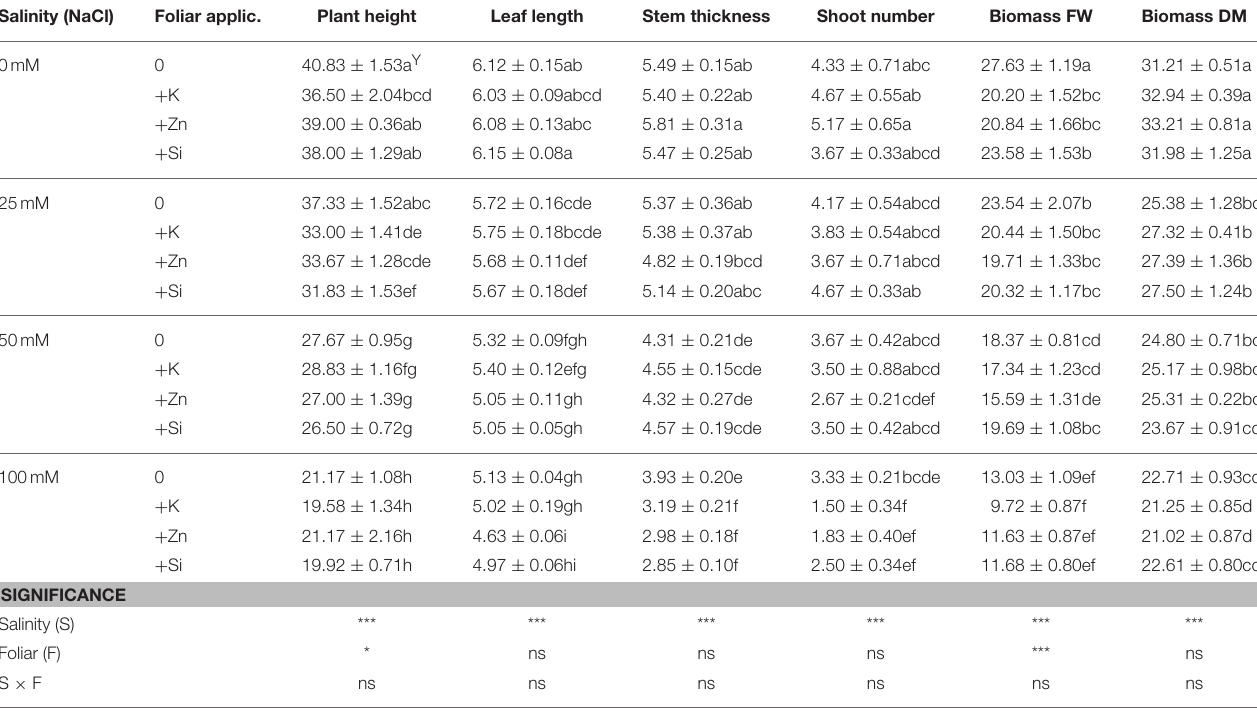
TABLE 1 | Effect of salinity levels (0–25–50–100mM NaCl) and foliar applications (no foliar, K, Zn, and Si) on lavender plant height (cm), leaf length (cm), stem thickness (mm), shoot number, biomass fresh weight (FW; g/plant), and biomass dry matter (DM; %) in plants grown hydroponically in perlite. Salinity (NaCl) Foliar